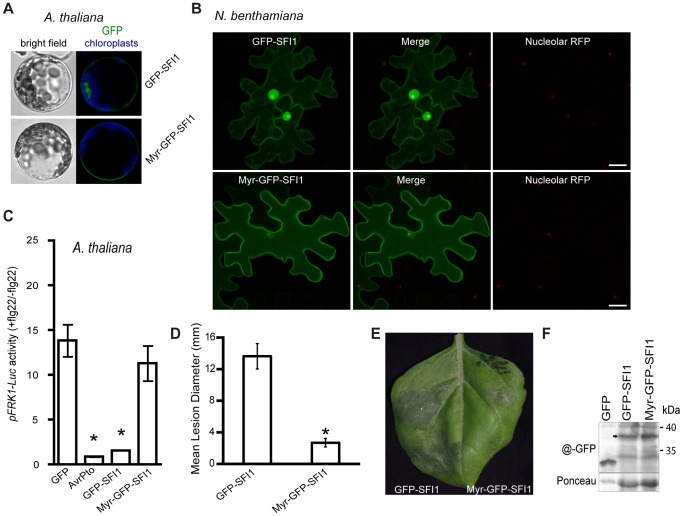
Importance of the nuclear localization of SFI1 for suppression of flg22-triggered pFRK1-Luc expression in A. thaliana and for P. infestans colonization in N. benthamiana.(A) Confocal microscopy of A. thaliana protoplasts expressing GFP-SFI1 or myr-GFP-SFI1 12 h after transfection. Representative optical sections of bright field and merged GFP (in green) and chloroplast (in blue) fluorescence images are shown. (B) Representative confocal microscope images of N. benthamiana cells expressing GFP-SFI1 and myr-GFP-SFI1 (left panels, in green) with the nucleolar marker RFP-fibrillarin (right panels, in red); the merged images are shown in the central panels. (C) Measurement of pFRK1-Luc reporter activity in A. thaliana protoplasts 6 h after flg22 treatment in the presence of GFP (control), AvrPto, GFP-SFI1 or myr-GFP-SFI1. Pooled data from four experiments are presented as mean ± SEM. Significant differences (p<0.05) in luciferase activity (denoted *) were determined using one-way ANOVA followed by Dunnett's multiple comparison test. (D, E) Effect of transient expression of GFP-SFI1 and myr-GFP-SFI1 on P. infestans colonization of N. benthamiana. Mean lesion diameter (D) and typical disease symptoms (E) are shown for P. infestans 7 days post-inoculation over sites on leaves where an effector construct was agro-infiltrated 1 day earlier. * represents statistical significance (p<0.001) using one-way ANOVA. (F) Immunoblot using anti-GFP antibody showing that both GFP-SFI1 and myr-GFP-SFI1 are stable and intact fusion proteins (arrowed) in planta.